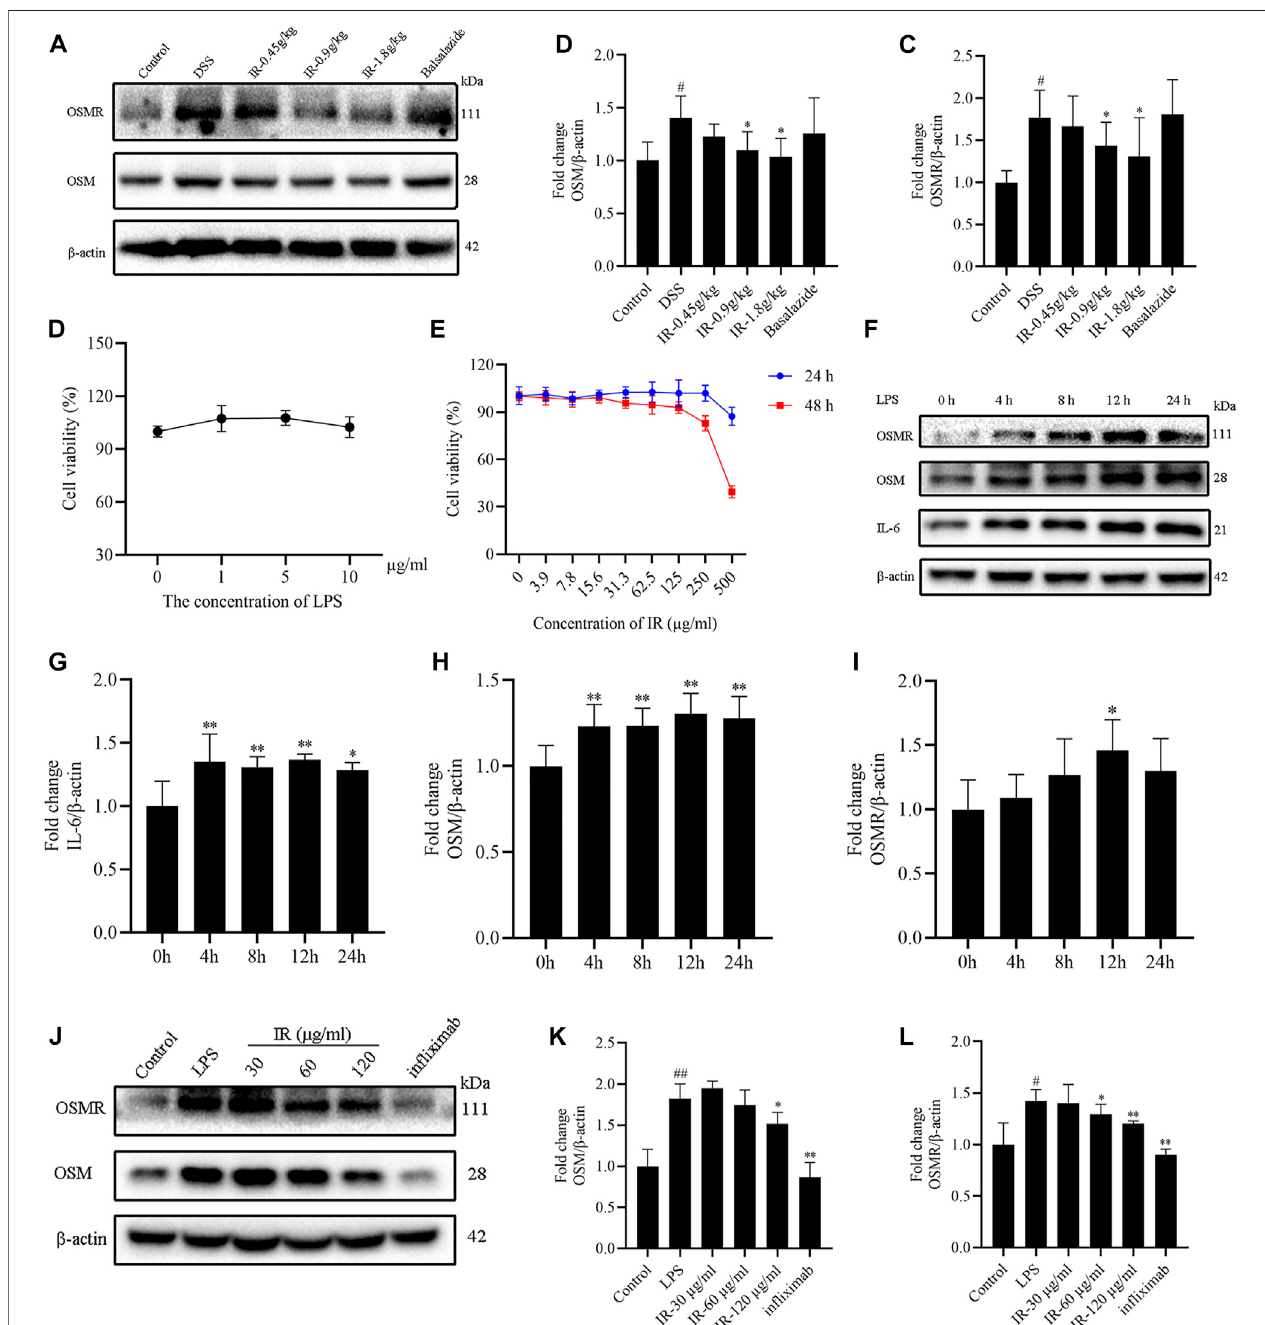
FIGURE6| IRameliorates UCinmicebyregulatingOSM/OSMRpathway. (A) Theprotein levels ofOSMandOSMRincolonofmicedetected bywesternblotting, with gray intensity analysis shown in panel (B,C) . (D) Cell viability of Caco2 cells treated with different concentrations of LPS for 24 h. (E) Cell viability of Caco2 cells treatedwithdifferentconcentrationsofIRfor24and48 h. (F) TheexpressionofOSM,OSMR,andIL-6proteinsofCaco2cellsdetectedbywesternblottingafter1 μ g/ml LPS stimulated, with gray intensity analysis shown in panel (G – I) . (J) The effect of IR on the expression of OSM and OSM proteins of Caco2 cells after LPS stimulated, with gray intensity analysis shown in panel (K,L) . All data were compared using one-way ANOVA, and p -values re fl ected differences between experimental groups ( n = 3).